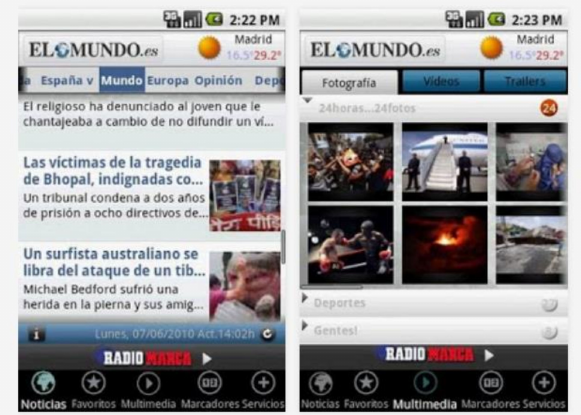
Figure 3. elmundo.es app (24 July 2012) (accessed on 17 April 2021). Compiled by the